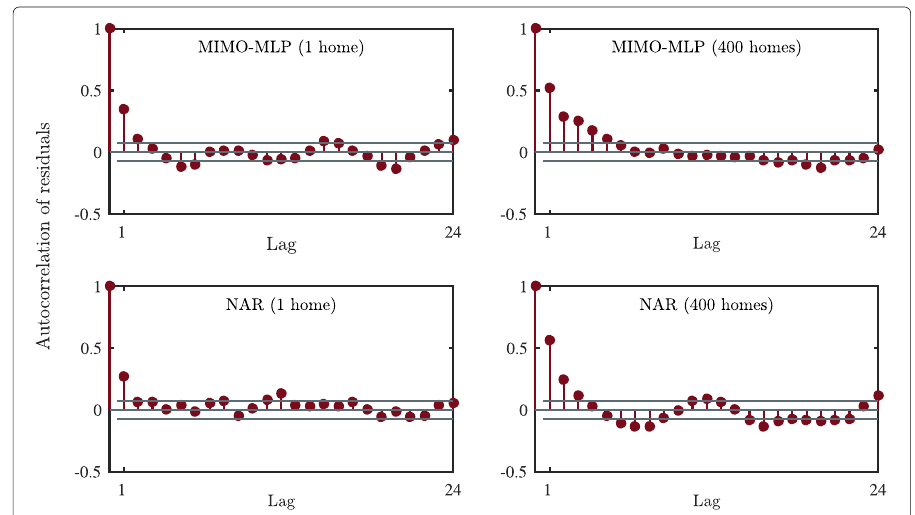
Fig. 5 Residuals of MIMO-MLP and NAR models predicting single home and 400 homes aggregation. Residuals are almost uncorrelated for single household. Yet, correlation becomes notable for 400